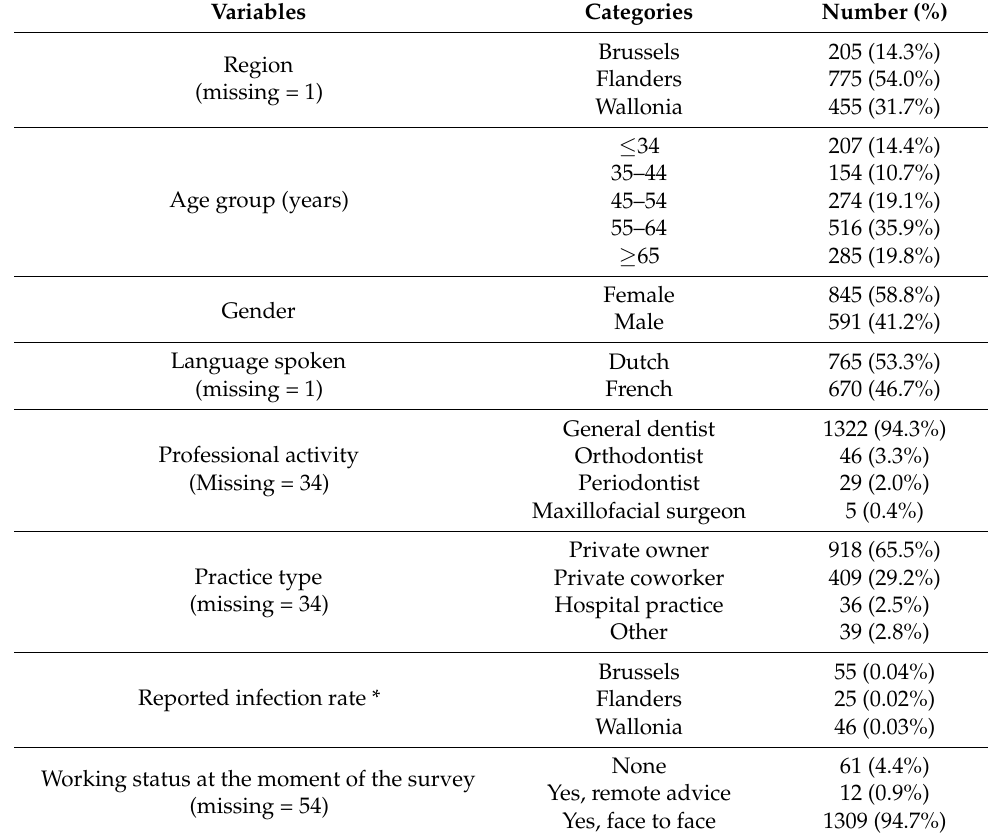
Table 1. Characteristics of the dentists who participated in the survey ( n =